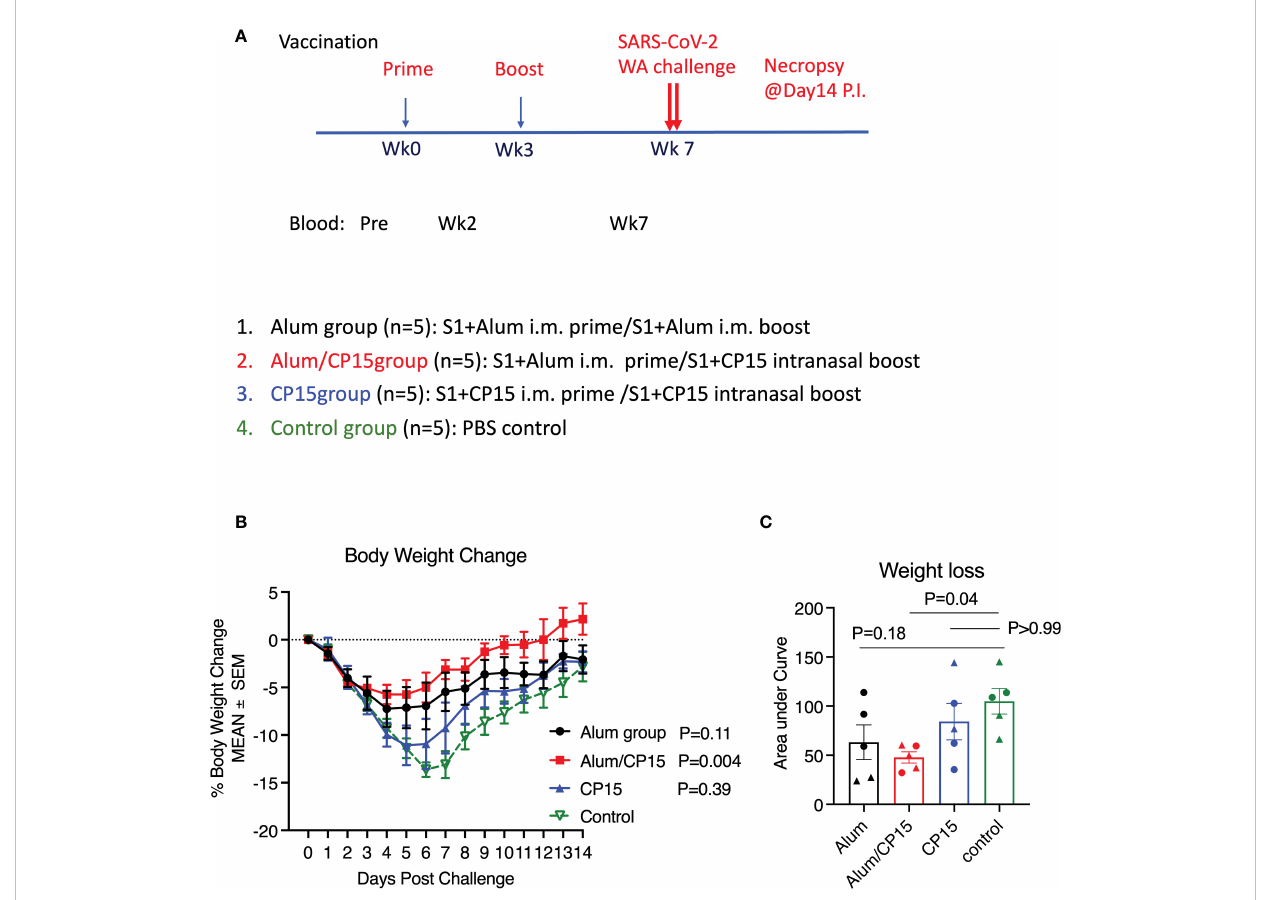
FIGURE 1 The Alum/CP15 group, which had been vaccinated with S1 protein adjuvanted with alum/CP15, showed signi fi cant protection against weight loss after challenge with SARS-Cov-2 WA strain in Syrian golden hamsters. (A) . Schematic diagram of vaccination/challenge schedules, and vaccination groups. (B, C) . Kinetics of body weight loss (B) and the area under curve of body weight loss (C) in hamsters after challenge with SARS-CoV-2 WA strain. N=5 for each group, and each dot in (C) represents one animal. Two-way ANOVA and Kruskal-Wallis tests with Dunn ’ s multiple comparison corrections were used to compare between the vaccinated groups and the control group. Mean ± SEM are